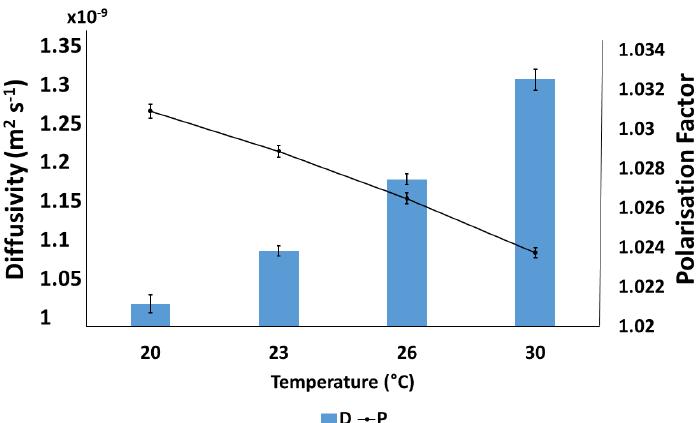
Figure 6. Polarization factor and diffusivity in the membrane.